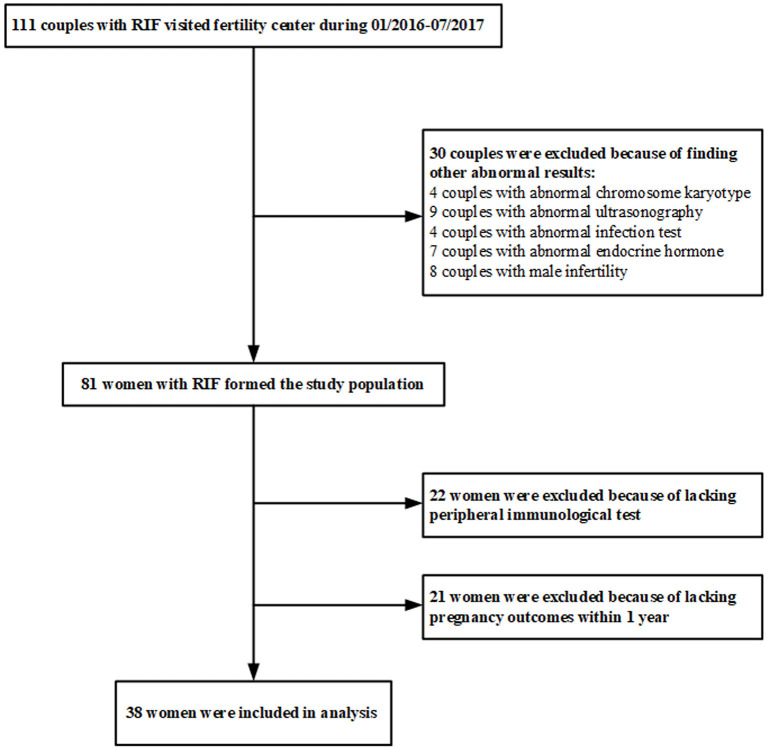
Flowchart listing the inclusion and exclusion criteria to select patients in this study.